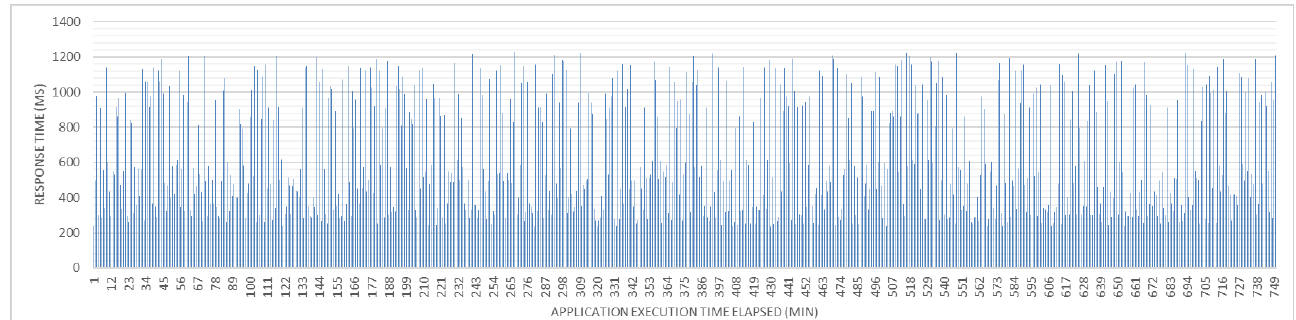
Figure 12. Response time over a period of 12.5 h when microservices were deployed using the arbitrary distribution model.